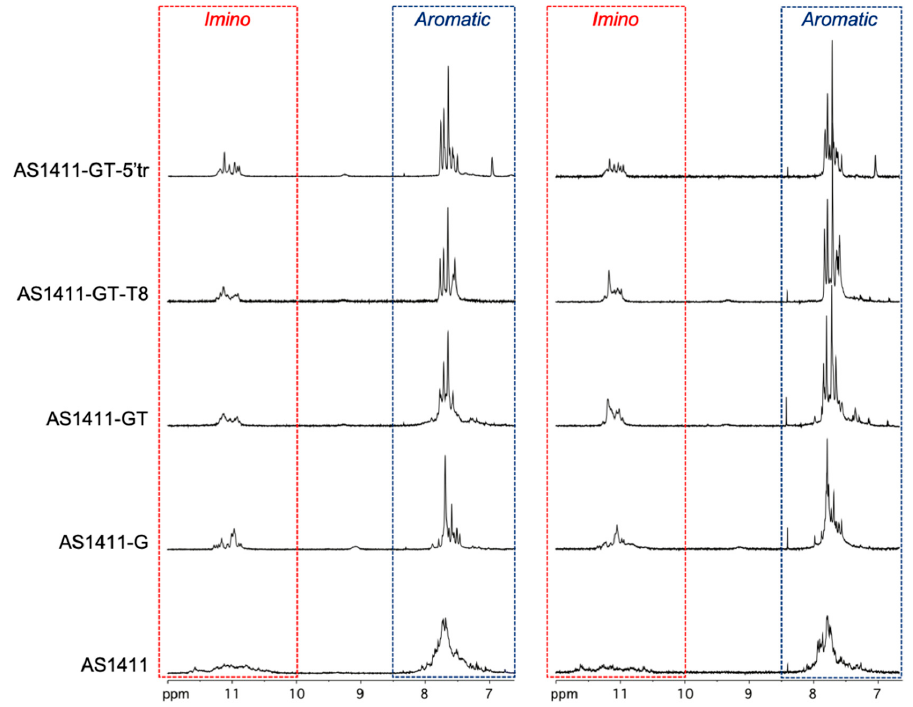
Figure 1. Imino and aromatic proton regions of AS1411 and its derivatives in K + (left panel) and PBS (right panel) buffers.